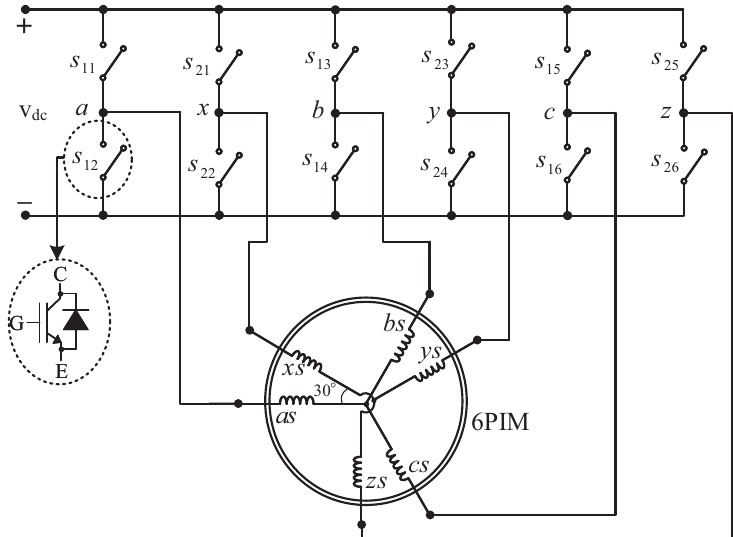
Figure 1. Six-phase two-level VSI-fed 6PIM.